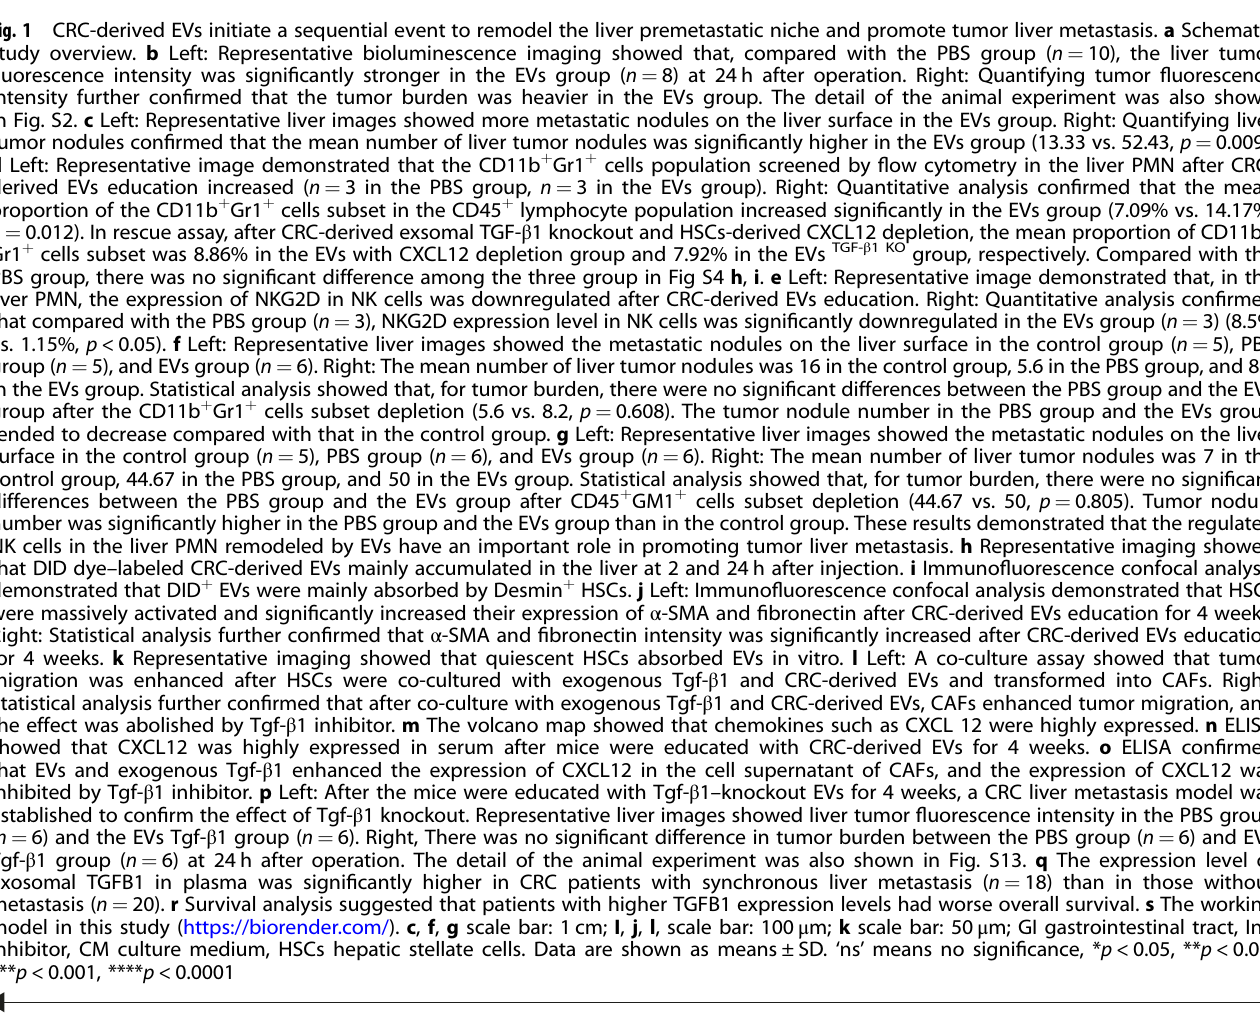
inhibited by Tgf- β 1 inhibitor. p Left: After the mice were educated with Tgf- β 1 – knockout EVs for 4 weeks, a CRC liver metastasis model was established to con fi rm the effect of Tgf- β 1 knockout. Representative liver images showed liver tumor fl uorescence intensity in the PBS group ( n = 6) and the EVs Tgf- β 1 group ( n = 6). Right, There was no signi fi cant difference in tumor burden between the PBS group ( n = 6) and EVs Tgf- β 1 group ( n = 6) at 24 h after operation. The detail of the animal experiment was also shown in Fig. S13. q The expression level